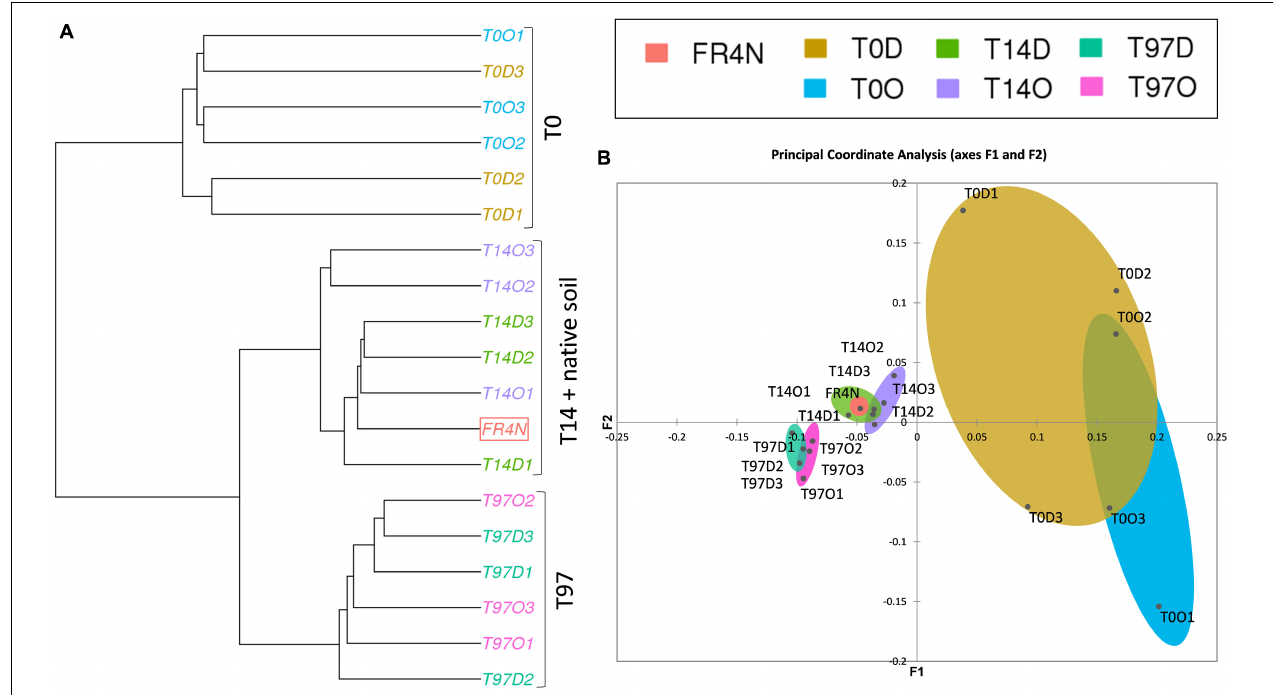
(beta diversity; Figure 6A ) highlighted three distinct groups: (i) T0, (ii) T14 and native soil, and (iii) T97. Results thus